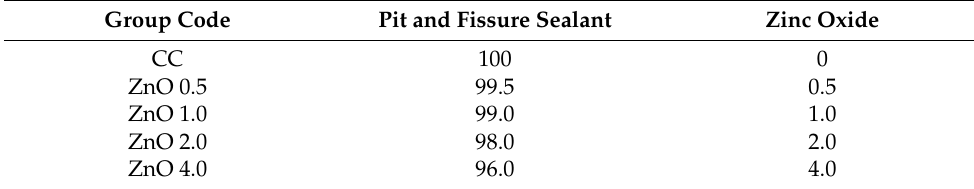
Table 1. Compositions of the control and experimental materials in this study